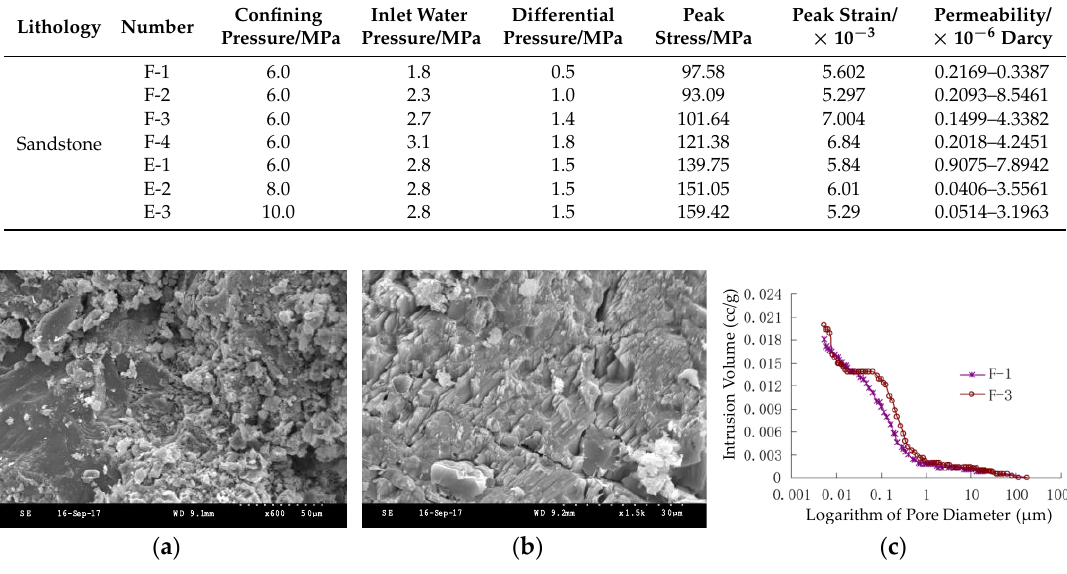
Figure 3. Microscopic structure of sandstone: ( a ) ×600 SEM photograph; ( b ) ×1500 SEM photograph; ( c ) mercury intrusion porosimetry (MIP) accumulated volume curves. Table 2. Pore structure of several samples.